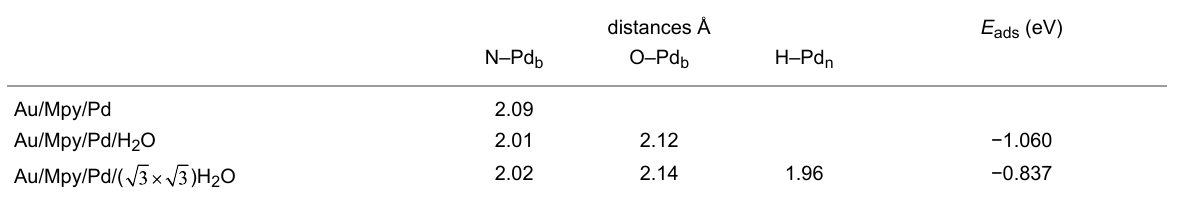
Table 1: Optimized geometry parameters and adsorption energies of a H 2 O monomer and a H 2 O hexagonal bilayer on a Au/Mpy/Pd contact within a ( )R30° geometry. The O–Pd b value refers to the water molecule bound via the O atom to Pd, and the H–Pd n distance is given for the H down atom in the water bilayer. E ads is the energy gain per H 2 O molecule upon adsorption with respect to a H 2 O molecule in the gas